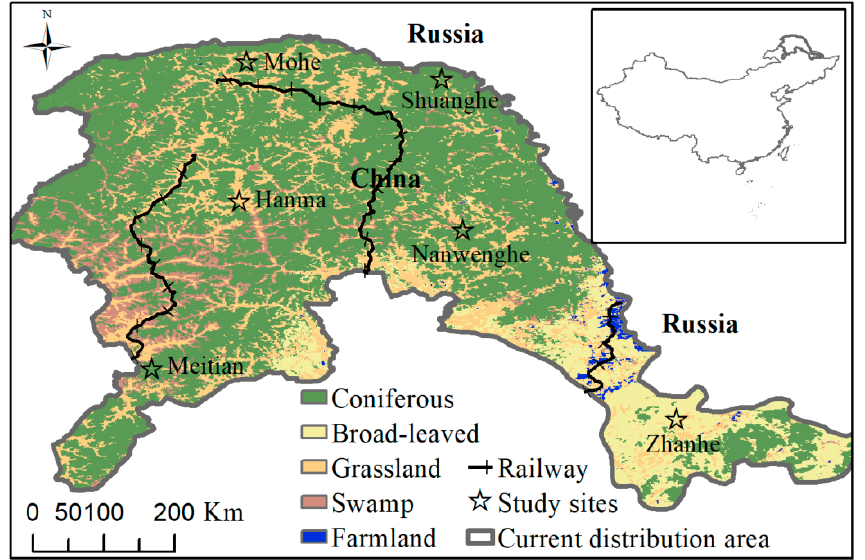
Figure 1. Location and vegetation of six sites where we studied the diet of moose ( Alces alces ) in northeastern China.